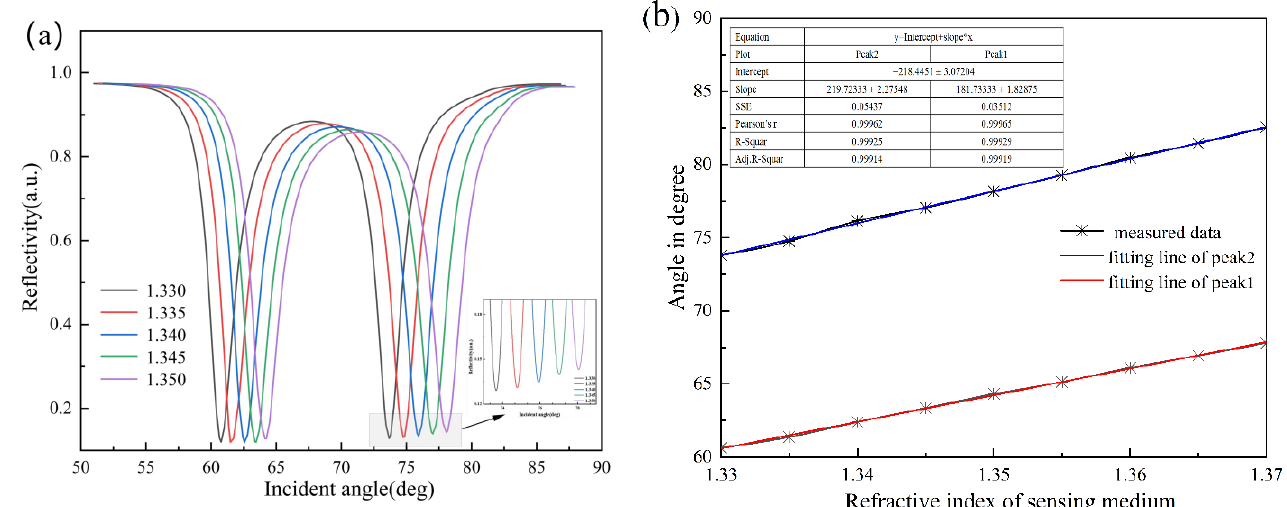
Figure 9. ( a ) Reflectance variation curve with a concentration of detection medium under angle modulation; ( b ) linear fit of the refractive index versus angle. Table 4. Comparison of the structure and performance of the sensors designed in different